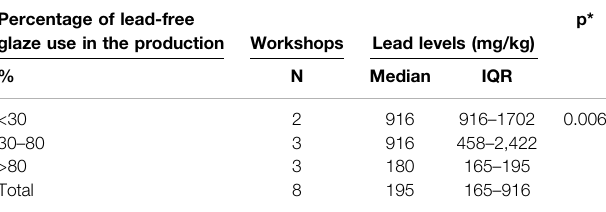
TABLE 3 | Soil lead levels (mg/kg) by workshop and use of lead-free glaze. Percentage of lead-free glaze use in the production